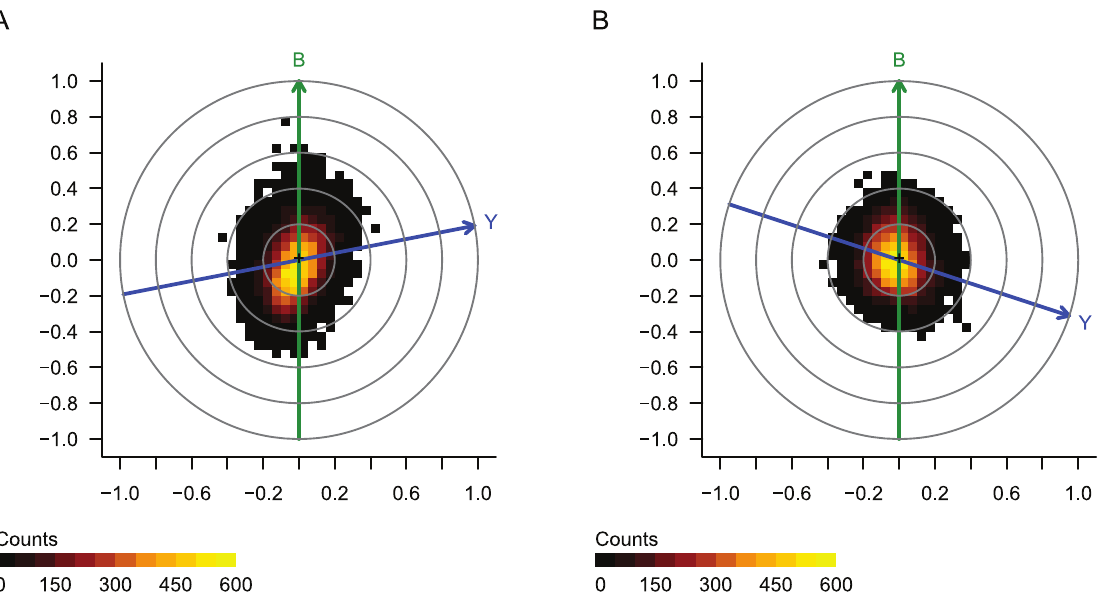
Figure 4. Case study 3: Ovarian tumors treated with platinum-based chemotherapy. Biasograms represent 119 tumors, with Y indicating the outcome vector (tumor response), and B indicating the bias vector defined as a binary indicator of microarray batch, as A) 2002-09-20 vs. all other dates, or B) 2002-10-23 vs. all other dates.